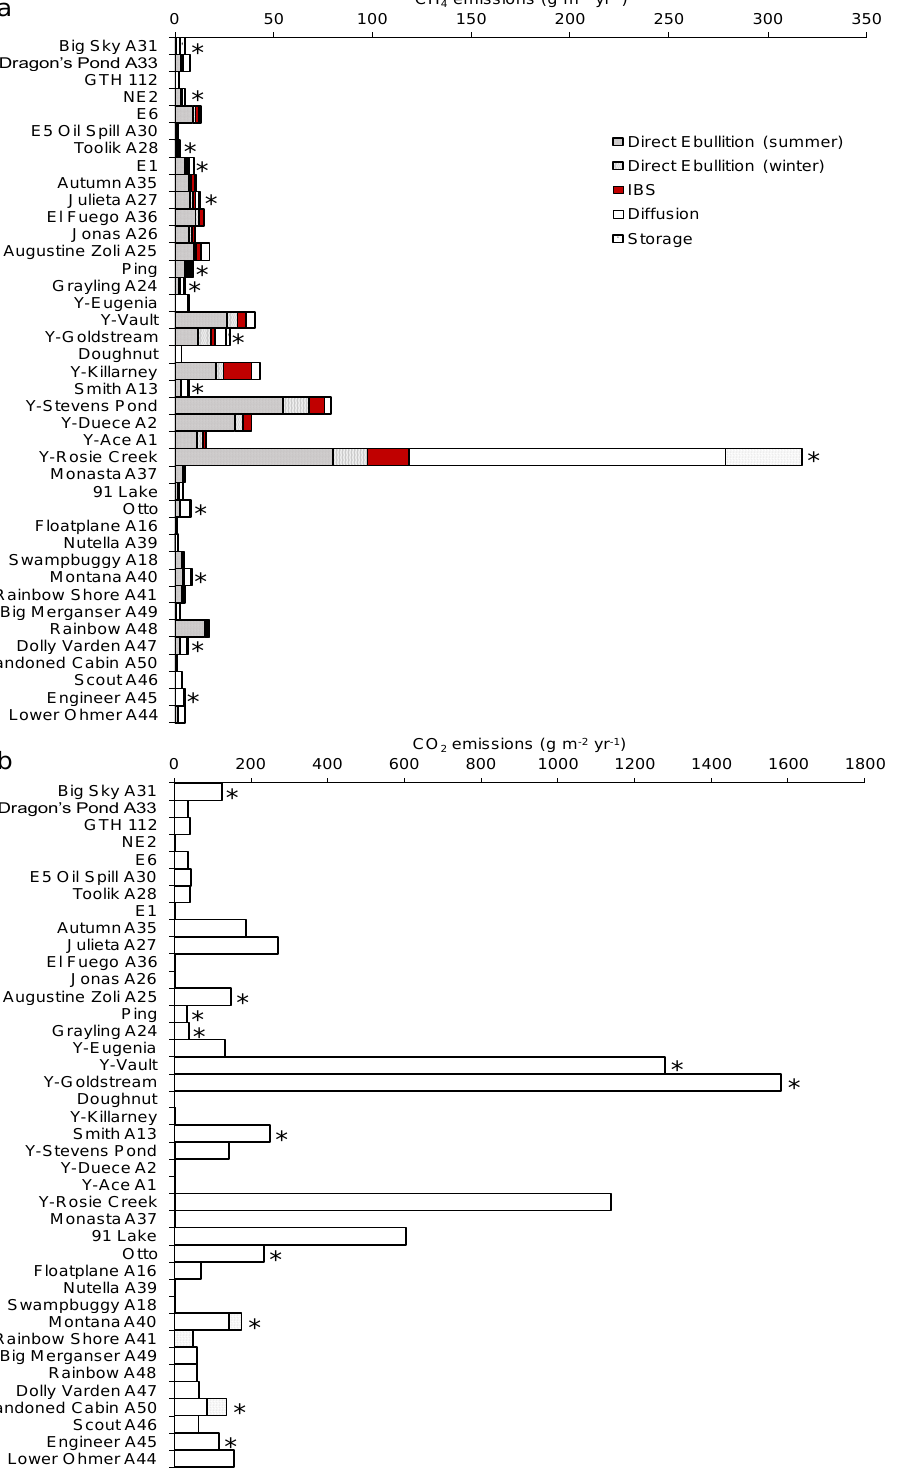
Figure 2. Total annual CH 4 (a) and CO 2 (b) emissions by mode from 40 lakes along a north–south latitudinal transect in Alaska. Yedoma lakes are indicated by “Y”. Lakes for which all emission modes were measured are indicated by “ ∗ ” (see Table 2). Panels (a) and (b) follow the legend shown in (a)